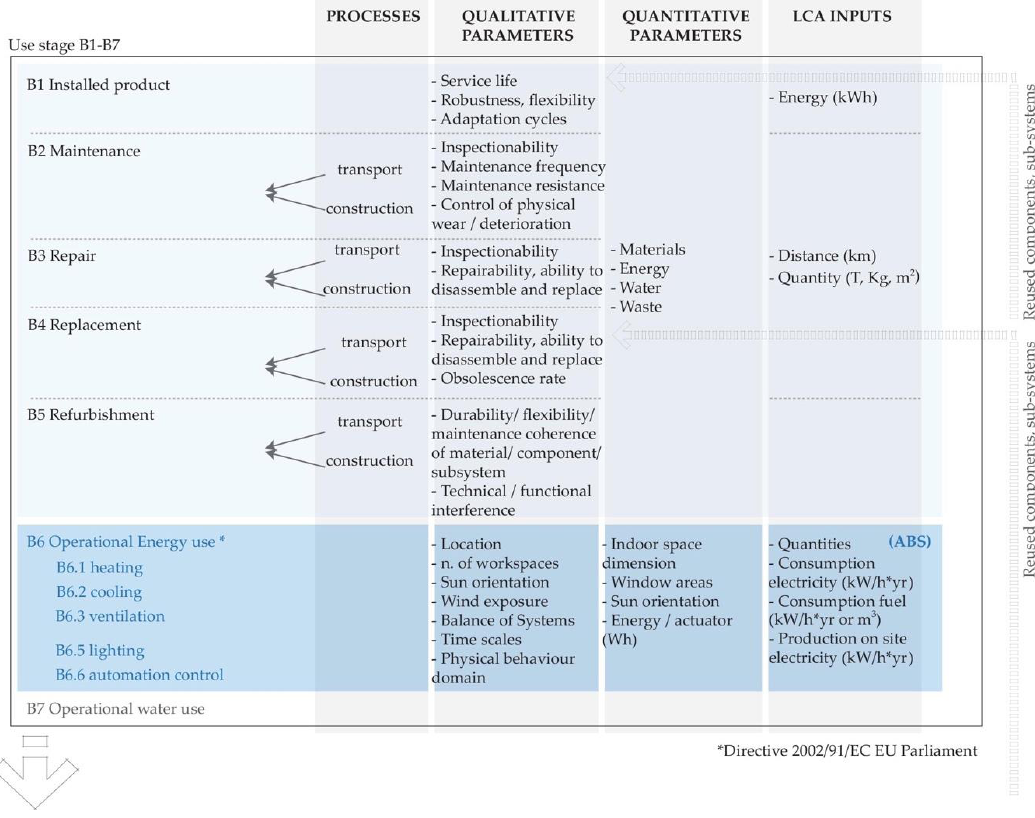
Figure 9. Mapping of LCA parameters in the phase B1-B7, focus on ABS parameters in phase B6-B7.